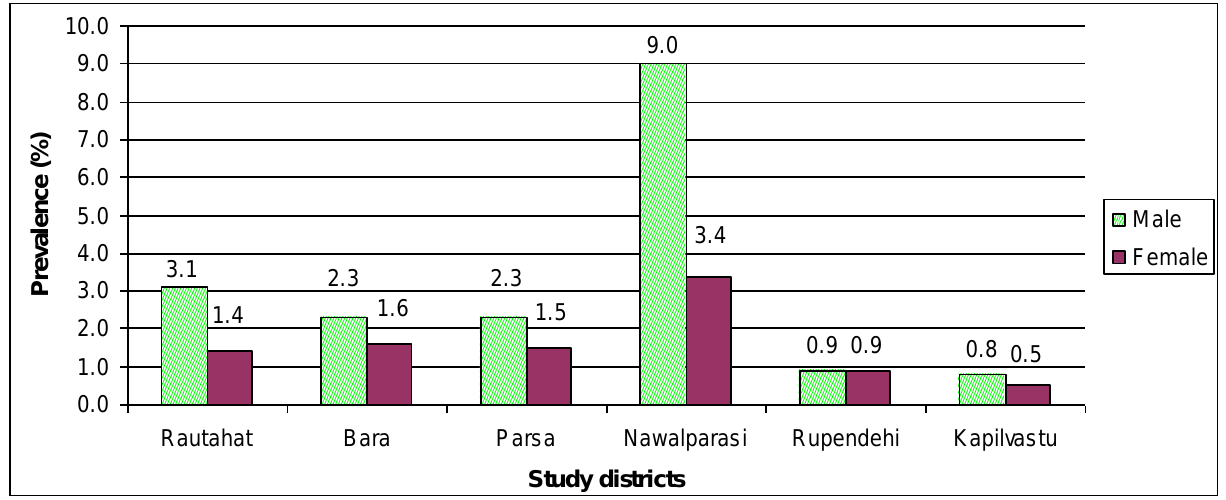
Figure 7. Prevalence of arsenicosis by sex (Adapted from Maharjan (2006)